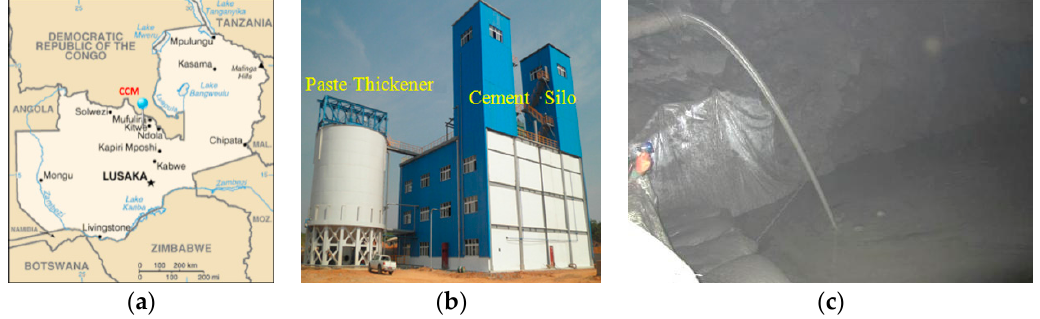
Figure 2. ( a ) Location of the Chambishi copper mine. Photographs of the ( b ) CPB plant and ( c ) underground stope backfill.